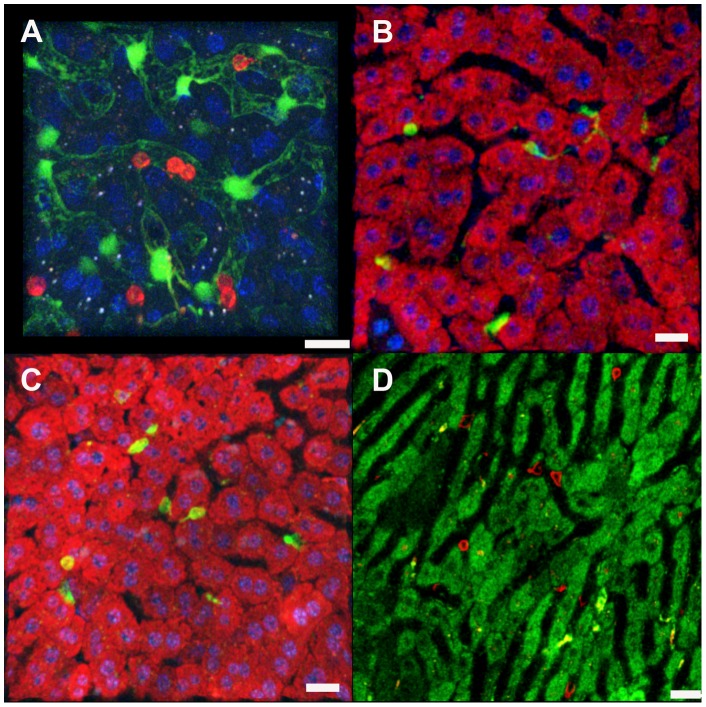
Behavior of CD8+ T cells in the liver of naïve and immunized mice.Representative IVM images of CD8+ T cells observed in naïve and P. yoelii immunized mouse livers. Note that in contrast to naïve mice, the T cells from immunized mice exhibit the characteristic amoeboid shape of activated effector cells and patrol the sinusoids with a leading edge and a trailing pseudopod. (A) 3D representation of a naïve Tie2-GFP mouse liver with fluorescent endothelia (green), anti-CD8a-PE labeled CD8+ T cells (red), and Hoechst stained nuclei (blue). (B and C) 3D projections of anti-CD8a-PE labeled CD8+ T cells (green) in the livers of mice immunized with (B) Pyfabb/f(−)or (C) Py-RAS. Hepatocyte mitochondria were labeled with MitoTracker (red) and nuclei were stained with Hoechst (blue). (D) 2D snapshot of the liver of a mouse immunized with Pyuis4(−) showing CD8+ T cells labeled with anti-CD8a-PE (red). Hepatocyte mitochondria labeled with MitoTracker (green). CD8+ T cells of immunized mice were monitored 2 weeks after the second booster. See Videos S1, S2, S3, S4 for the corresponding movies. Scale bars 20 μm.